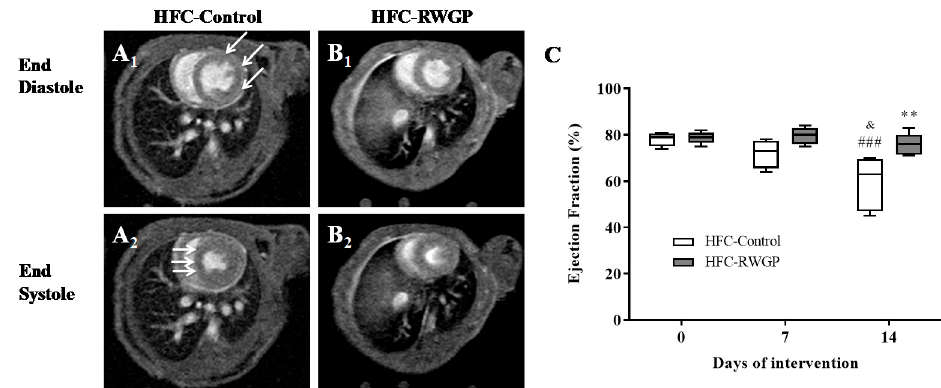
Figure 7. Impact of RWGP supplementation on contractile cardiac function of SR-B1 KO / ApoER61 h / h mice fed with atherogenic diet. Cardiac images were obtained by Cine-FLASH MR. Representative diastolic or systolic end pictures are shown for mice fed with HFC-Control ( A1 , A2 ) or HFC-RWGP diet ( B1 , B2 ) at day 14, respectively. White arrows indicate diastolic dysfunction (A1) and septum hypokinesia (A2) in HFC-Control mice. ( C ) Quantification of ejection fraction at baseline and after 7 and 14 days of dietary interventions. Data are shown in box plots (box, 25th to 75th percentiles; whiskers, median and IQR) ( n = 5–7). ### p < 0.001 compared to day 0; & p < 0.001 compared to day 7; ** p < 0.01 vs. HFC-Control based on two-way ANOVA.